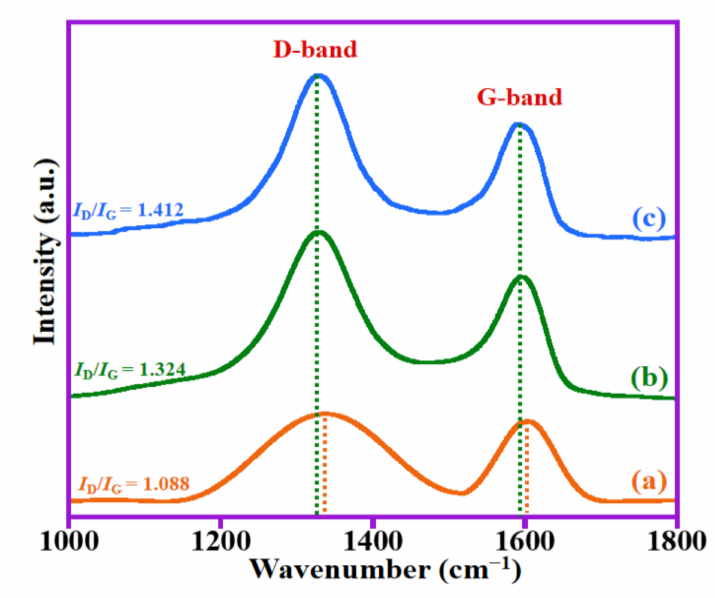
Figure 4. Raman analysis of ( a ) GO, ( b ) NDG, and ( c ) (1%) ZnO–MnCO 3 /(1%-NDG). The sample morphology was examined and the FESEM micrographs of pure NDG, un-doped (1%) ZnO–MnCO 3 catalyst, and (1%) ZnO–MnCO 3 /(1%-NDG) nanocomposite